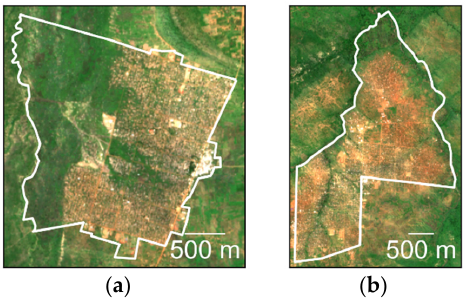
Figure 4. OSM refugee settlement boundaries (shown in white) at ( a ) Nyumanzi and ( b ) Pagirinya with background true-color Sentinel-2 imagery from 2019.